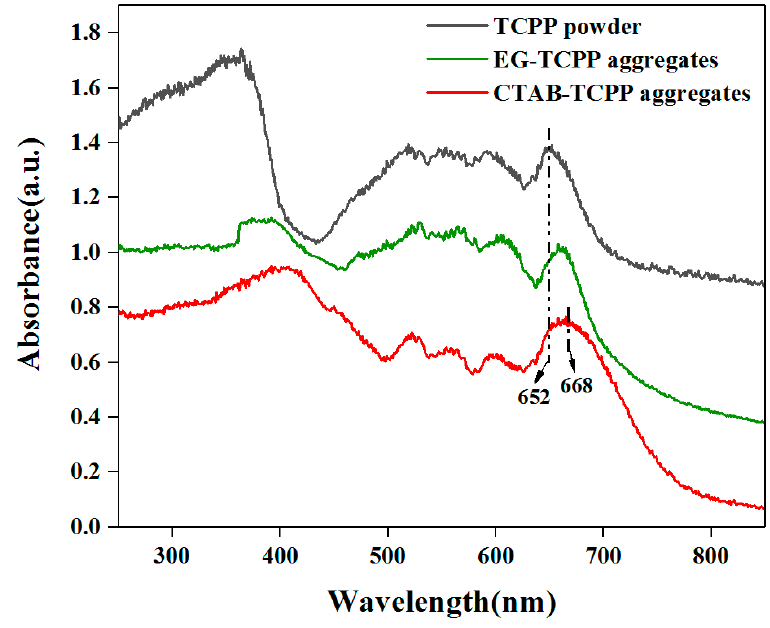
Figure 6. UV-Vis diffuse reflectance spectroscopy of different photocatalysts.